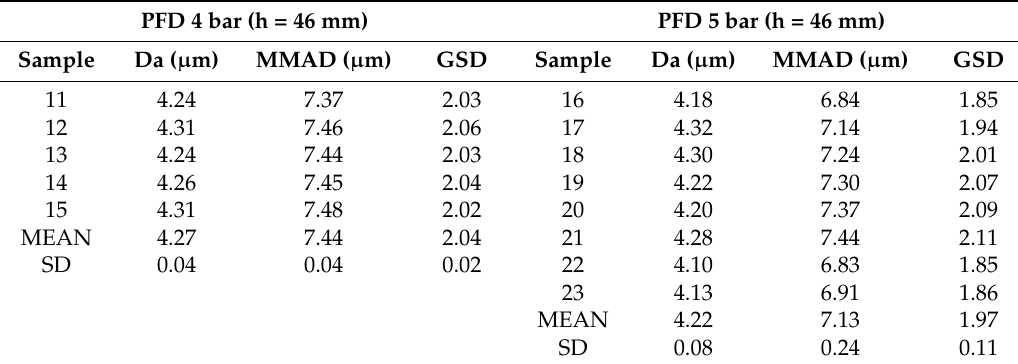
Table 2. PFD experimental results at h = 46